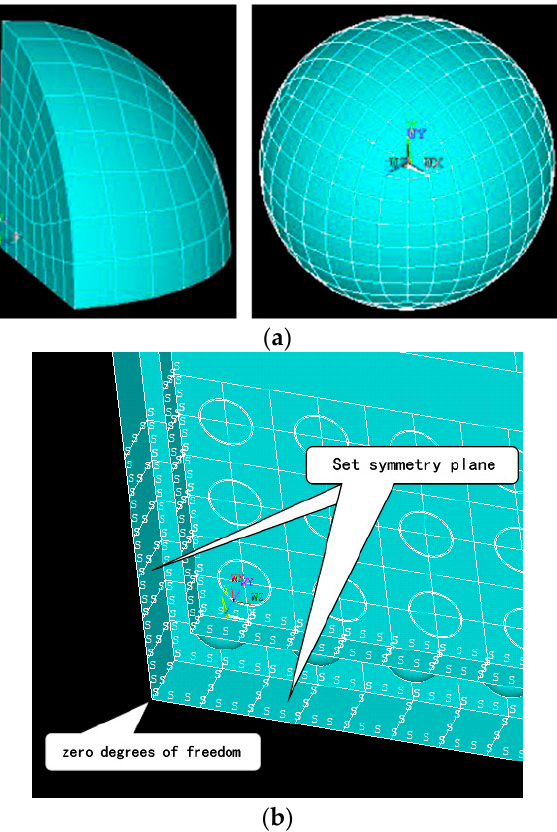
Figure 6. Mesh and boundary set in simulation model: ( a ) Meshes on welded ball of specimen; ( b ) Boundary conditions of symmetry plane and zero DOF.